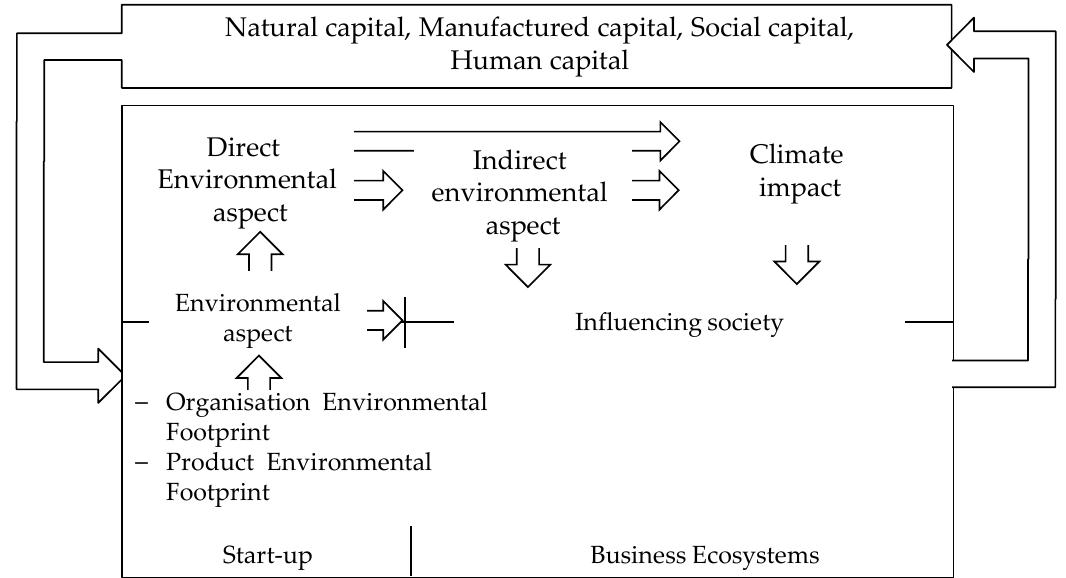
Figure 11. The entity’s impact on the environment, climate and society. Source: author’s own devel- opment.